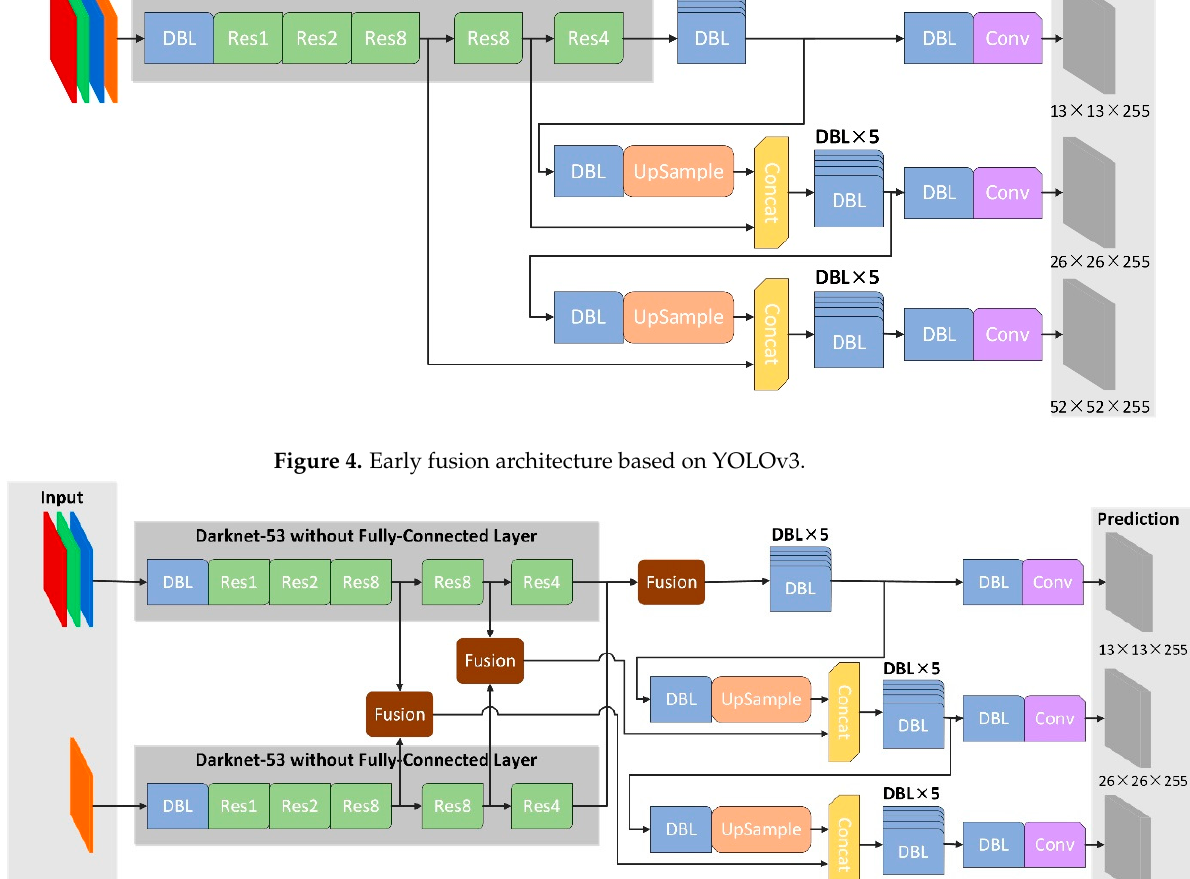
Figure 5. Late fusion architecture based on YOLOv3.